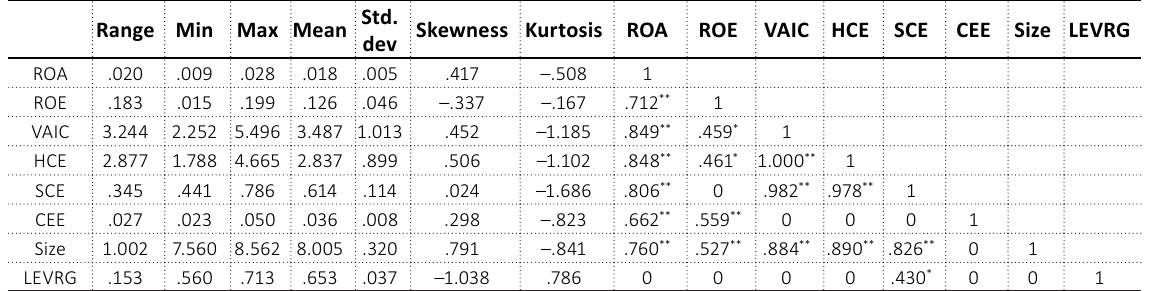
Table 1. Descriptive statistics and correlation matrix